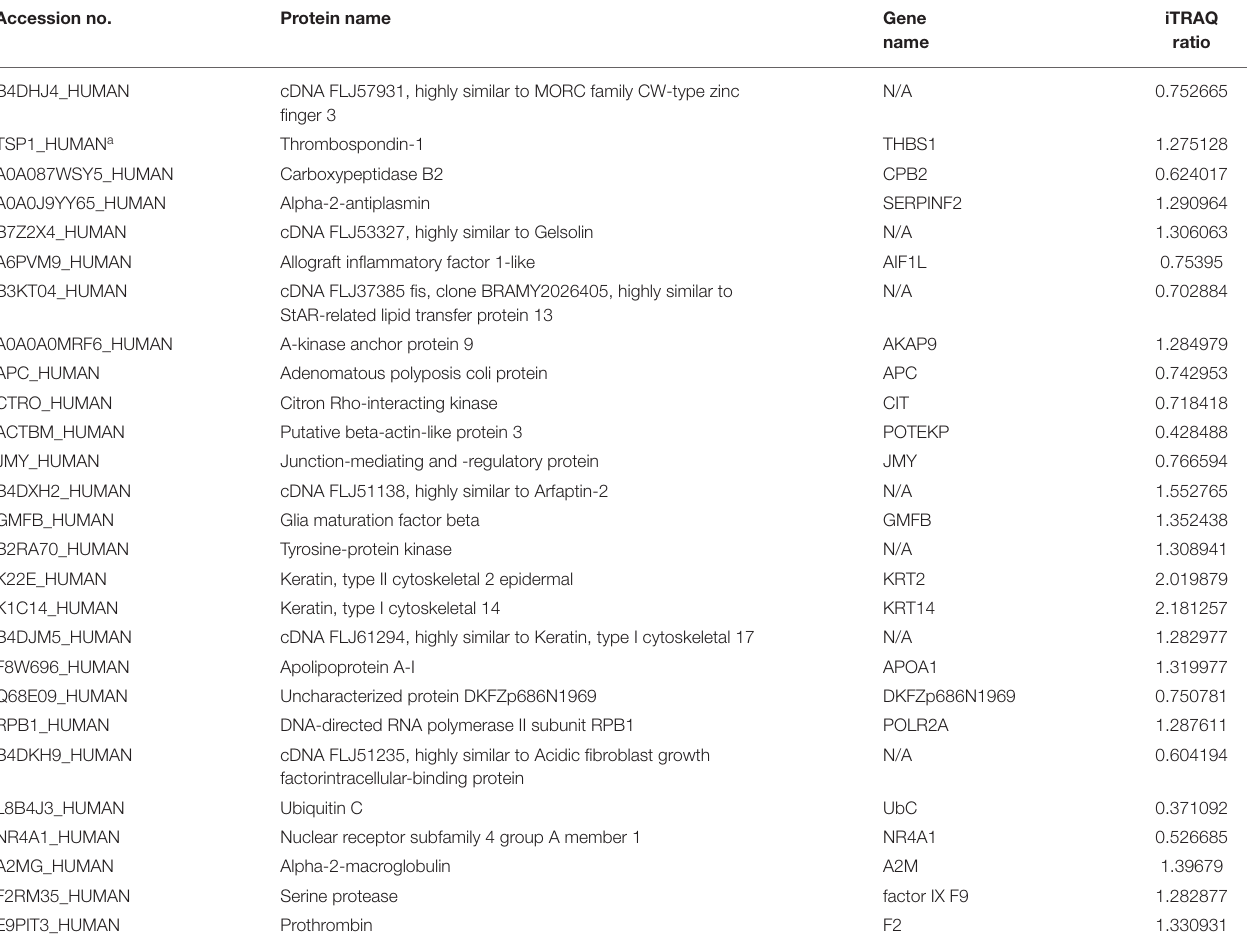
TABLE 3 | Differentially expressed proteins related with fibrosis in TC0668 mut - vs. TC0668 wt -infected HeLa cells at 18h p.i. Accession